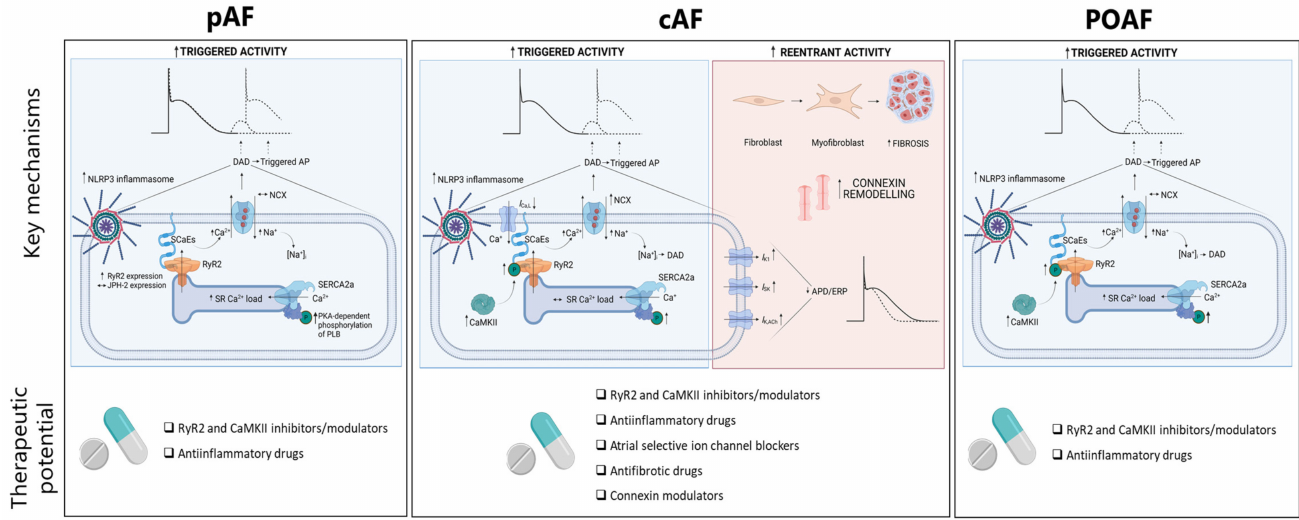
Figure 1. Key pathways for formation of AF. Triggered activity is common in all 3 forms of AF, which includes Ca 2+ handling abnormalities, RyR2-channel dysfunction and triggered activity in form of DADs. Re-entry activity is commonly observed in patients with cAF, but less frequent and consistent in patients with POAF and pAF. The NLRP3 inflammasome is upregulated in all forms of AF, but plays the biggest role as an acute trigger in patients that present with POAF. AP, action potential; APD, action potential duration; cAF, chronic atrial fibrillation; CaMKII, Ca 2+ -calmodulin protein kinase II; DAD, delayed afterdepolarization EAD, early afterdepolarization; JPH-2, junctophilin-2; PKA, protein kinase A; ERP, effective refractory period; NCX, Na + /Ca 2+ -exchanger; NLRP3 inflammasome, NACHT, LRR and PYD domains-containing protein 3; pAF, paroxysmal AF; PLB, phospholamban; POAF, post-operative AF; RyR2, ryanodine receptor type-2; SCaE, spontaneous Ca 2+ -release events; SERCA, sarcoplasmic reticulum Ca 2+ -ATPase type-2a; SR, sarcoplasmic